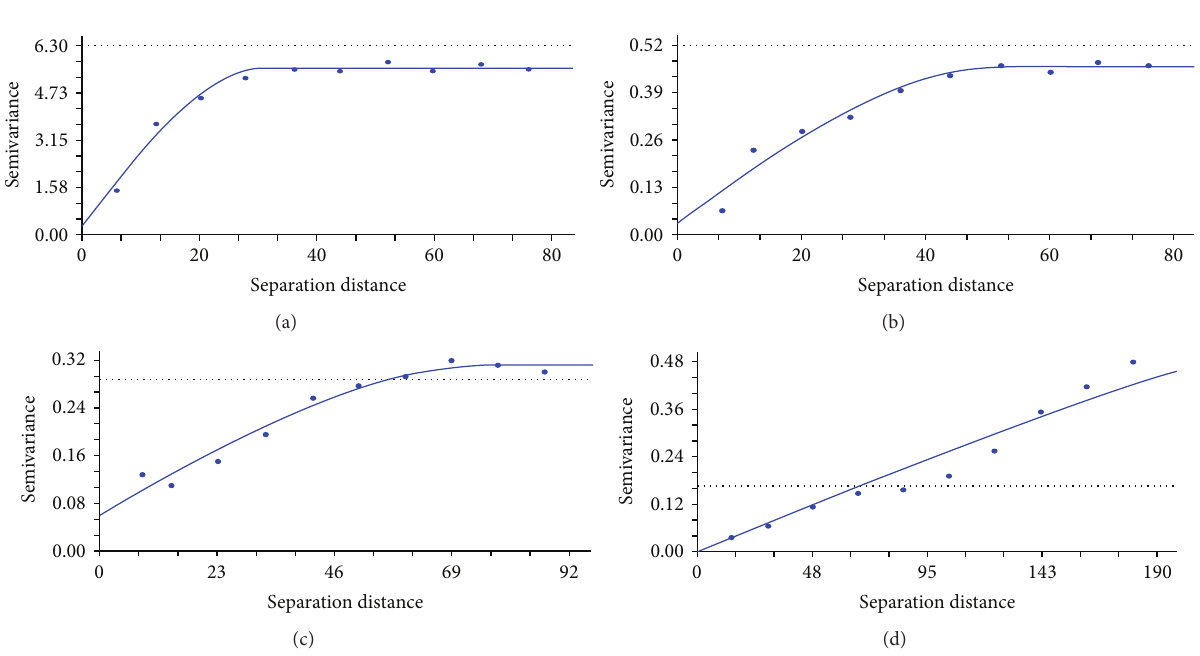
Figure 7: (a) Semi-variogram models for soil As. (b) Semivariogram models for straw As. (c) Semivariogram models for husk As. (d) Semivariogram models for grain